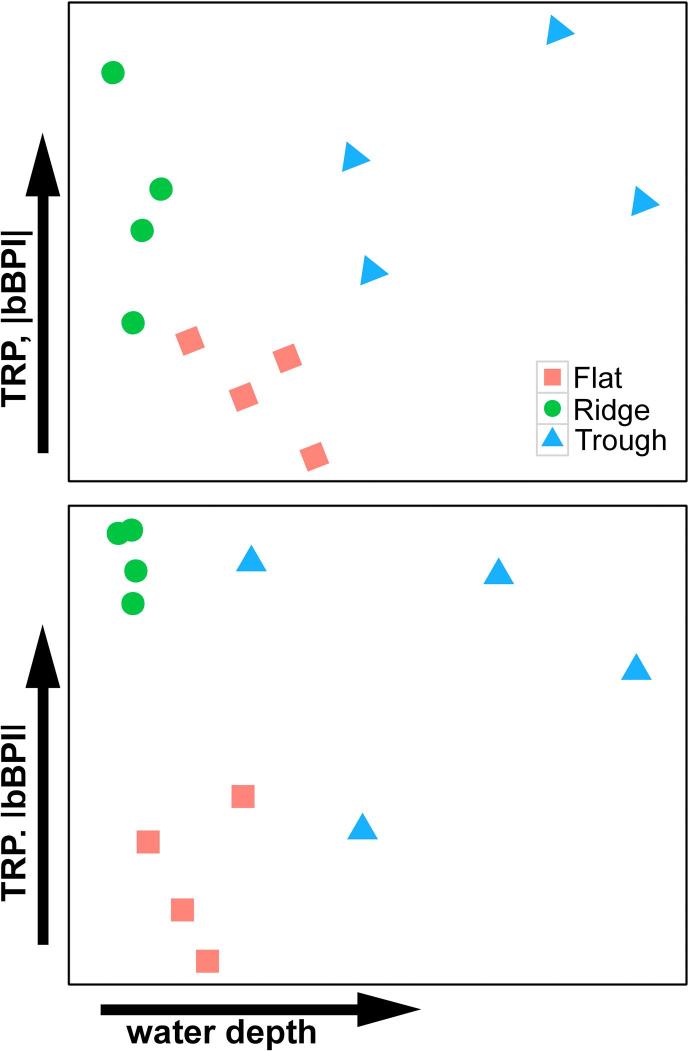
Interpreted megafauna morphospecies composition nMDS for APEI6 samples. Two-dimensional representations of nMDS developed on Bray-Curtis resemblance matrix calculated from square-root transformed megafauna composition by abundance data. (a) nMDS plot developed including only metazoan fauna. (b) nMDS plot developed including metazoans and xenophyophores. Arrows indicating the (non-linear) trend in water depth and bathymetric derivatives suggested for each axis.